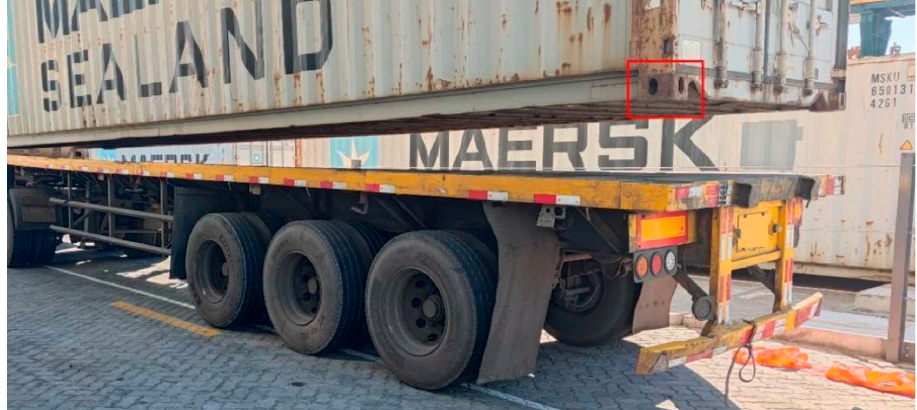
Figure 2. Container